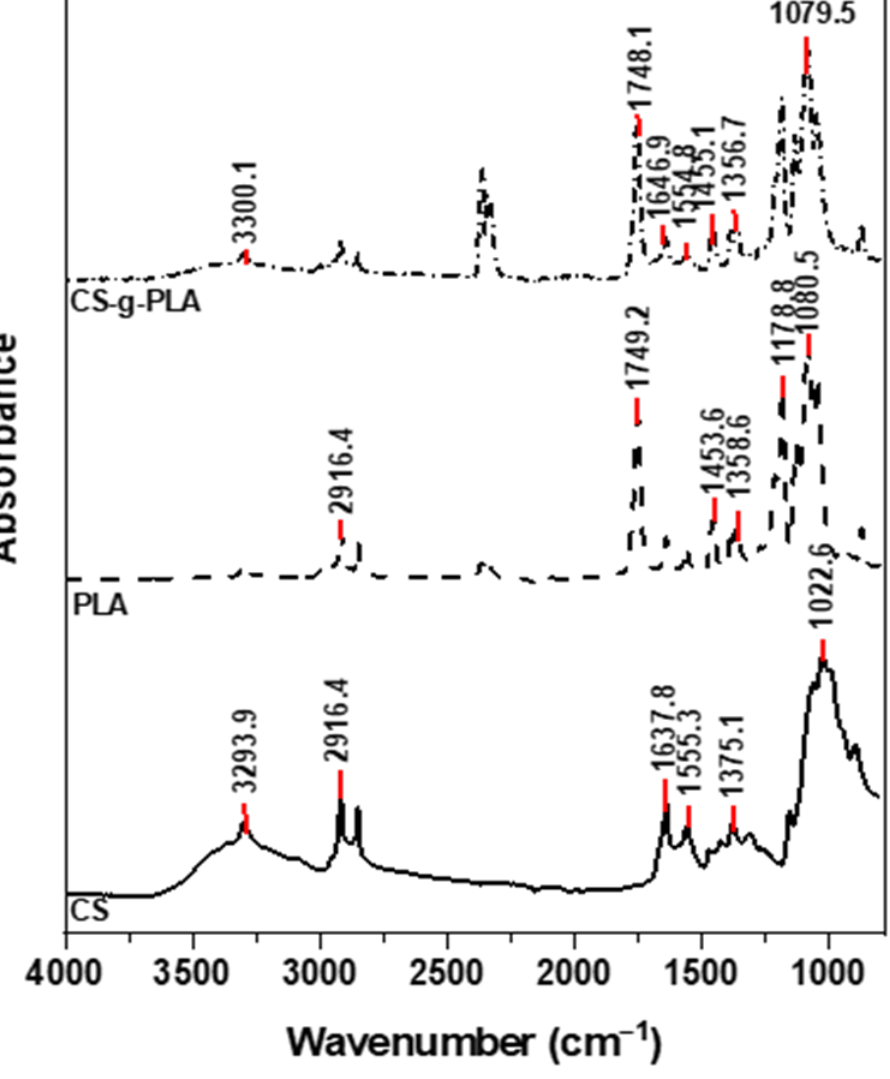
Figure 1. FTIR spectra of PLA, CS, and their corresponding CS-g-PLA copolymers.